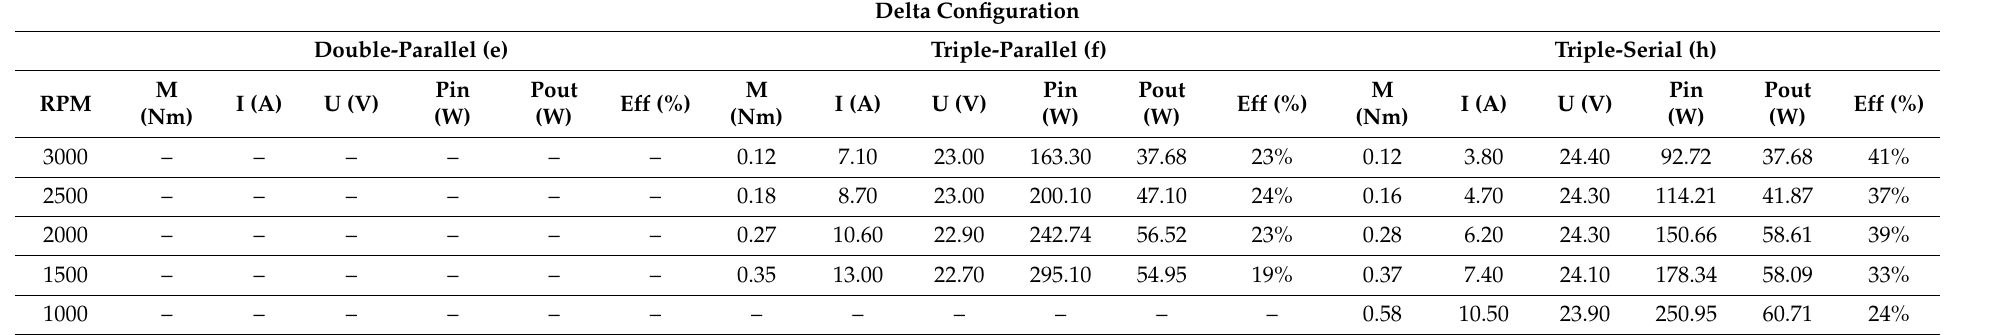
Table 2. Measured results of delta inner winding